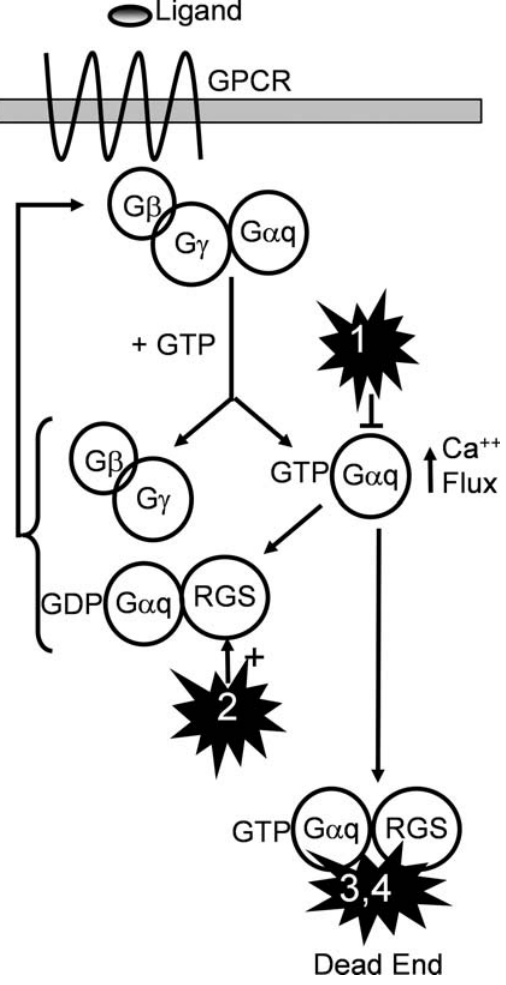
Figure 8. Models for Mechanism of Action Four models of small-molecule action are presented. In model 1, the small-molecule acts directly and uniquely as an antagonist of G- a q. In model 2 the small-molecule acts directly and uniquely as an agonist of the RGS protein’s GAP activity. In models 3 and 4 (our preferred models), the small molecule interacts with both the RGS protein and G- a q, leading to an increased affinity of RGS for the complex and/or an ‘‘ abortive ’’ complex (failure of G- a q to recycle). All models lead to reduction of the GPCR signal through the activated G- a q. DOI: